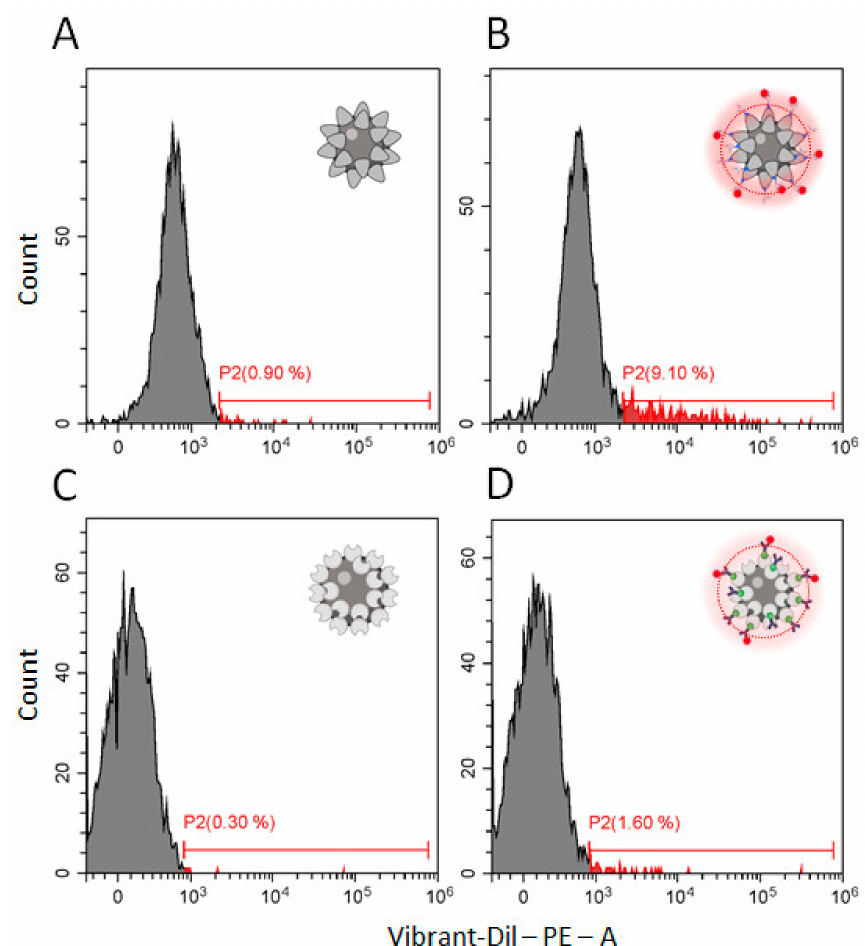
Figure 5. Efficiency of the PSMA(+)SEVs capture by complexes composed of PSMA-specific DNA aptamers and antibodies. ( A ) SPMBs with the surface functionalized by –N 3 groups (no aptamer) incubated with Vibrant-Dil-labeled SEVs (negative control); ( B ) SPNBs modified with PSMA–Apt via alkyne-azide cycloaddition and incubated with Vibrant-Dil-labeled SEVs; ( C ) SPMBs with the surface functionalized by streptavidin (no antibodies) incubated with Vibrant-Dil-labeled SEVs (negative control); ( D ) SPMBs modified by antibodies against PSMA via a biotin–streptavidin link and incubated with Vibrant-Dil-labeled